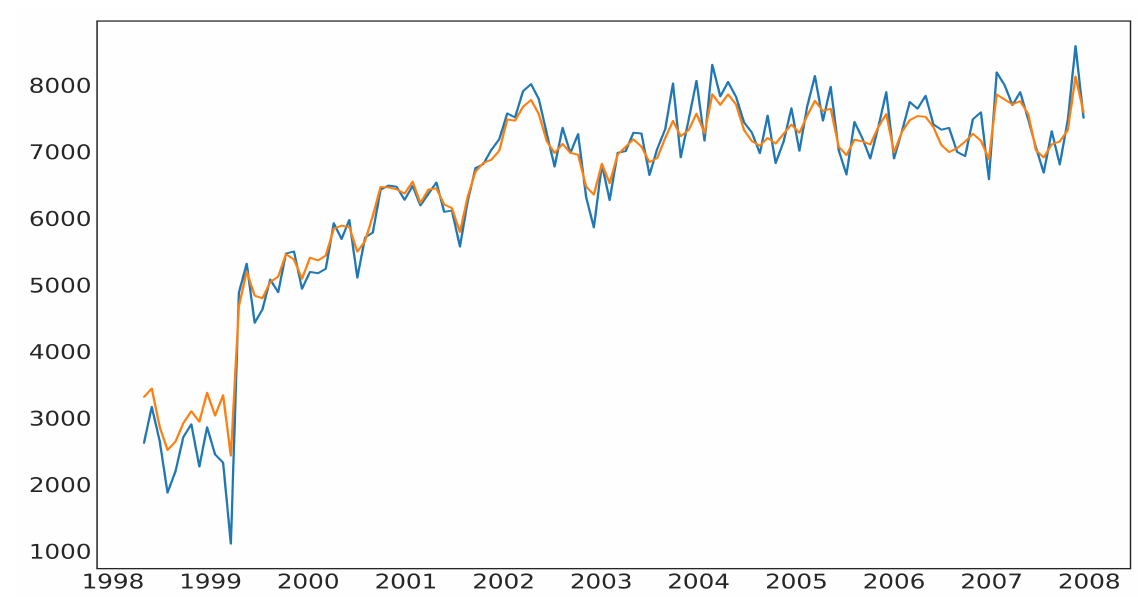
Figure 5. The forecasted values for crime by a tuned random forest model.